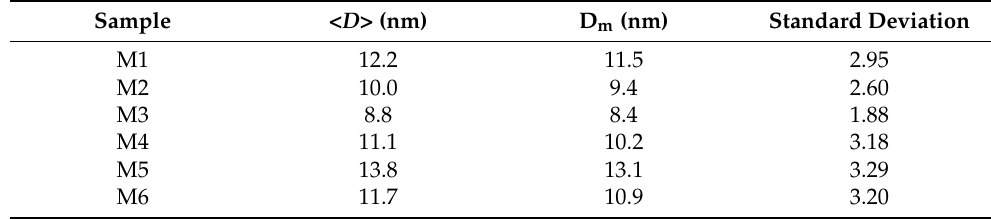
Figure 6. TEM images obtained for the M1–M6 samples. ( a , b ) are TEM images for M1 sample, ( c , d ) are TEM pictures for M2 sample, ( e , f ) are TEM images for M3 sample, ( g , h ) are TEM images for M4 sample, ( i , j ) are TEM pictures for M5 sample, while ( k , l ) are TEM magnifications for M6 sample. Table 1. TEMvaluesformeanparticlediameterandD m isthemodevalueobtainedfromthePSDhistogram.